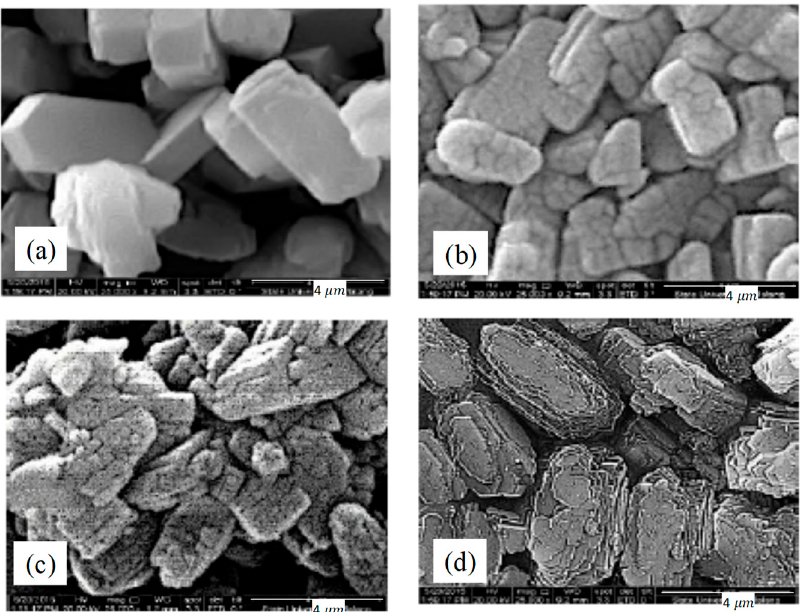
Figure 5. Morphologies of the adsorbents ( a ) ZSM ‐ 5 comm ( b ) ZSM ‐ 5 deAl ( c ) ZSM ‐ 5 deSil ( d ) ZSM ‐ 5 deSildeAl .